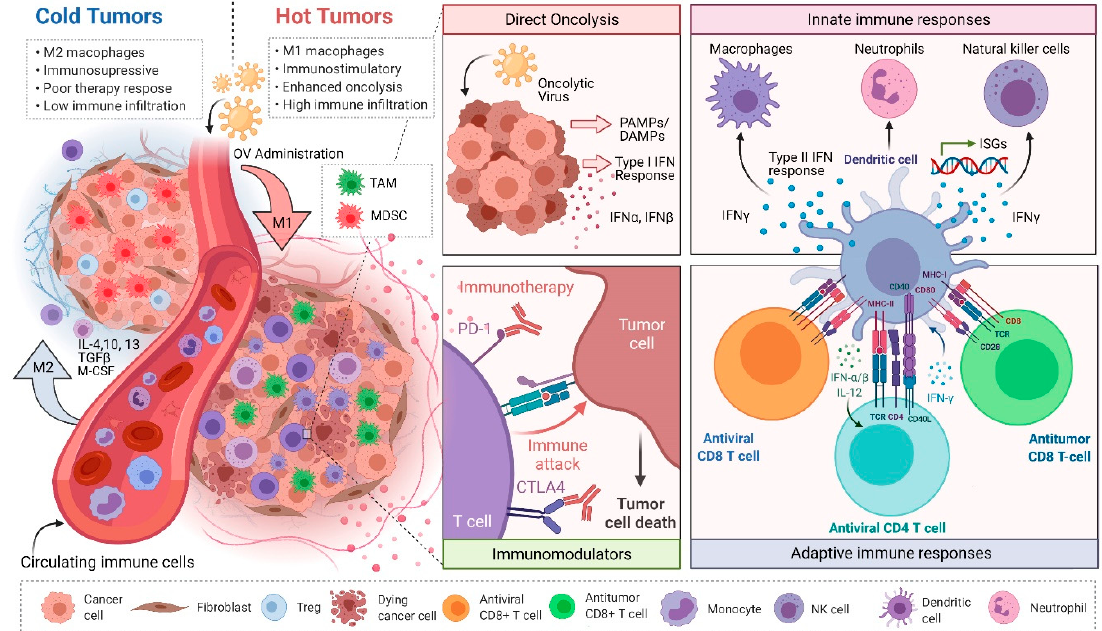
Figure 1. Overturning the tumor microenvironment (TME)-mediated immunosuppression using oncolytic virus (OV) immunotherapy. Administration of OVs can turn “cold” tumors “hot”, release otherwise inaccessible tumor antigens to be processed by antigen-presenting cells (APCs) via oncolysis and also drive the activation of innate immune cells. Further, OVs alone or in combination with ICB therapy can repolarize immunosuppressive immune cells, such as TAMs and MDSCs, to antitumor phenotype and support the development of antitumor immunity. Abbreviations: OV: Oncolytic virus; PD-1: Programmed cell death protein 1; CTLA-4: Cytotoxic T-lymphocyte-associated protein 4; IFN: Interferon; ISG: Interferon stimulating genes; IL: Interleukin; PAMPs: Pathogen-associated molecular patterns; DAMPs: Damage-associated molecular patterns; TGF β : Transforming growth factor beta; CSF: Colony-stimulating factor.